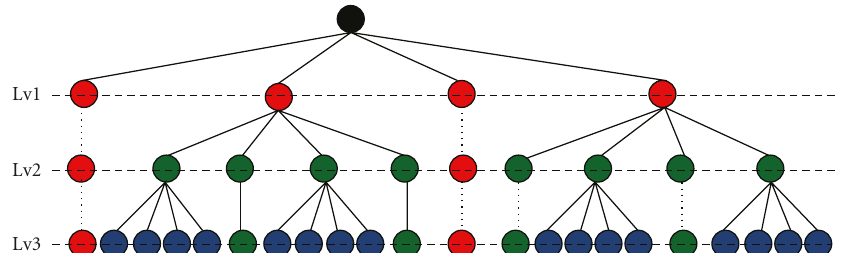
Figure 5: The idea of constructing an MRMEH.